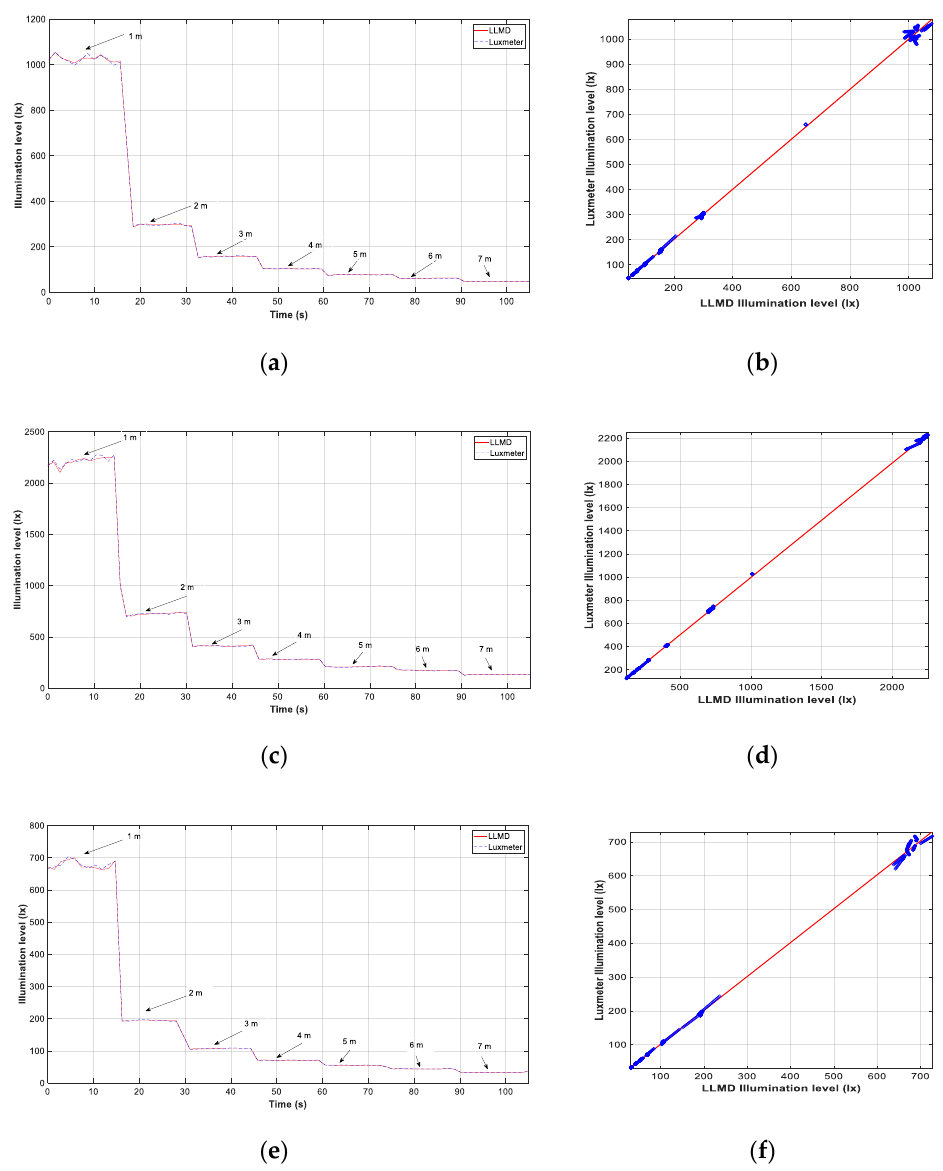
Figure 16. Illumination level test. ( a ) Comparison between luxmeter and LLMD with CDO lamp; ( b ) Luxmeter vs. LLMD; ( c ) Comparison between luxmeter and LLMD with SON lamp; ( d ) Luxmeter vs. LLMD; ( e ) Comparison between luxmeter and LLMD with HPL lamp; ( f ) Luxmeter vs. LLMD. Table 6. Comparative measurements lighting level.